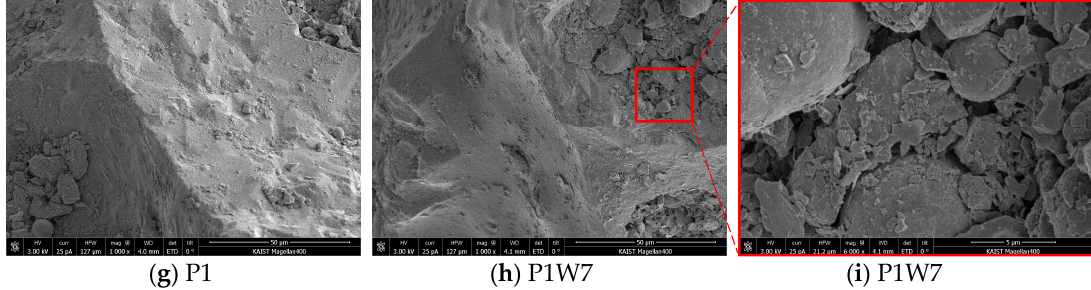
Figure 4. Scanning electron microscopy (SEM) images of raw bottom ashes, pre-carbonation and wet